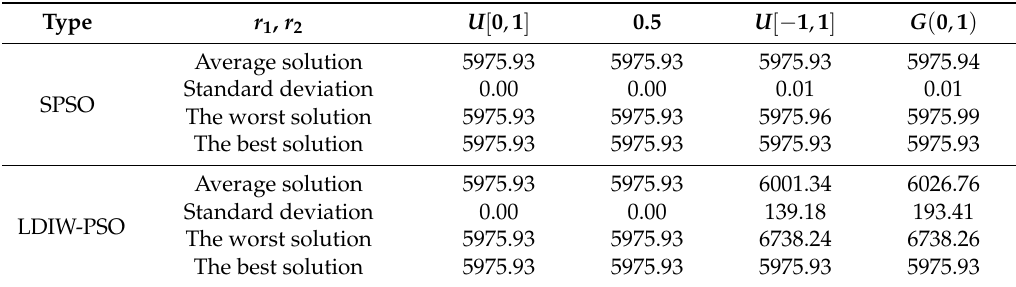
Table 4. Comparisons of standard PSO and LDIW-PSO algorithms with different types of random values for pressure vessel design.